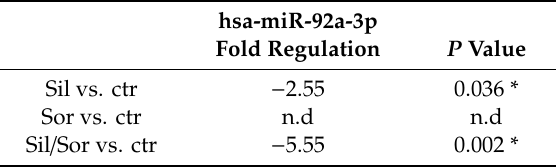
Table 3. Fold regulation of miRNA levels detectable in the medium of silybin (sil), sorafenib (sor), and silybin/sorafenib-treated cells versus untreated cells (ctr). * highly significant.